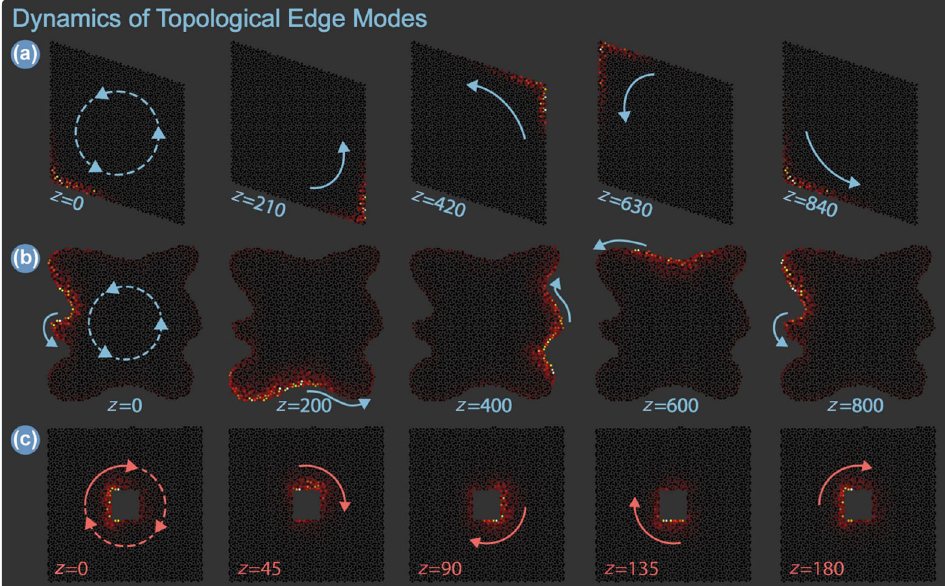
FIG. 7. Propagation dynamics of a topological edge wave packet moving along the edges of the quasicrystalline lattice (with A 0 ¼ 1 . 75 ), for (a) square and (b) arbitrary-shaped lattices, and (c) for a square hole in the lattice. Here, z denotes the propagation distance in units of the period of the periodic modulation. The propagation is always unidirectional, with no reflections or scattering into the bulk, even for sharp edges and arbitrary shapes. Because the Chern number is þ 1 , the propagation is counterclockwise around the outer edge, as in (a) and (b), but clockwise in a hole inside the quasicrystal, as in (c).